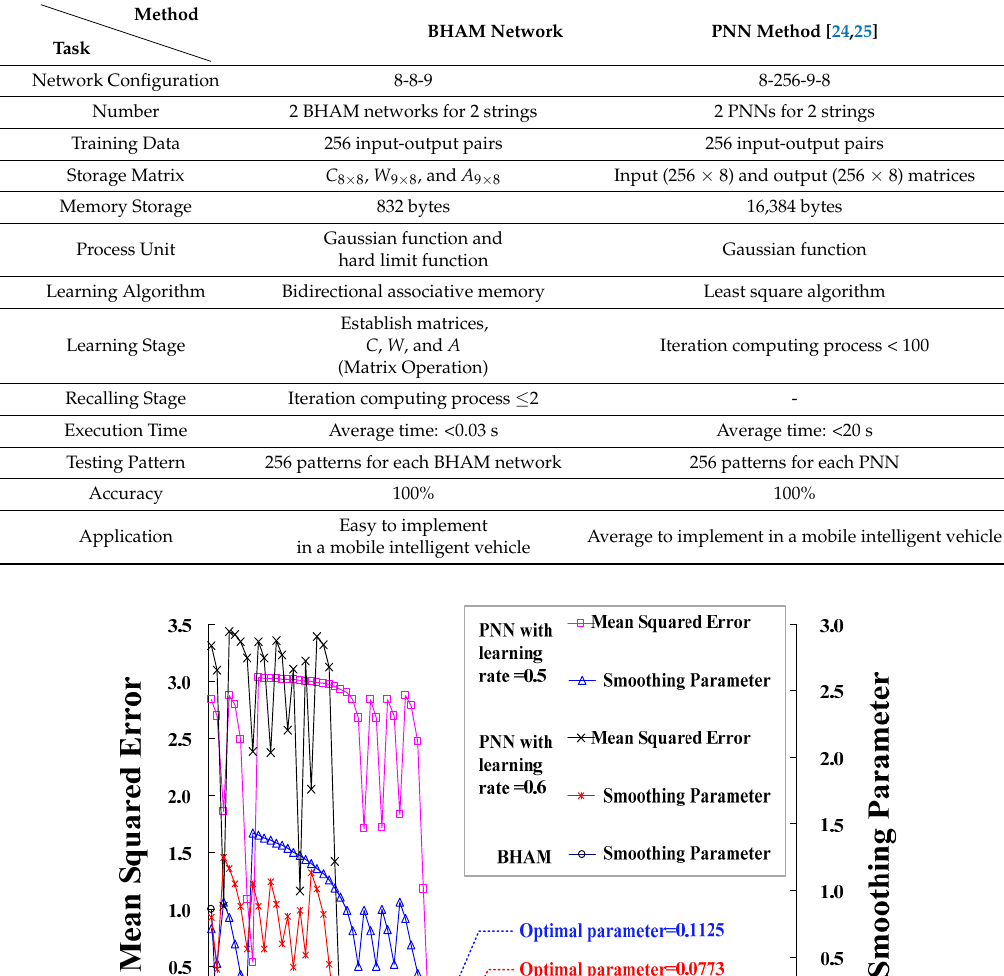
Table 4. Comparison of the proposed model and multi-layer PNN method.